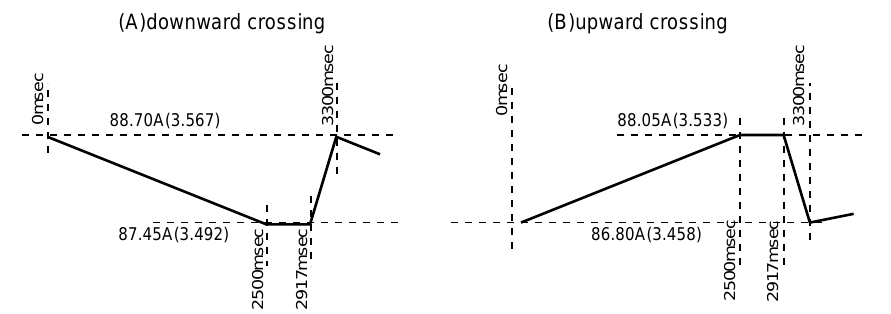
FIG. 4. Excitation patterns of QD magnets in (A) downward and (B) upward resonance crossing experiments. The horizontal axis shows the time after the master trigger and the vertical axis shows the QD current.